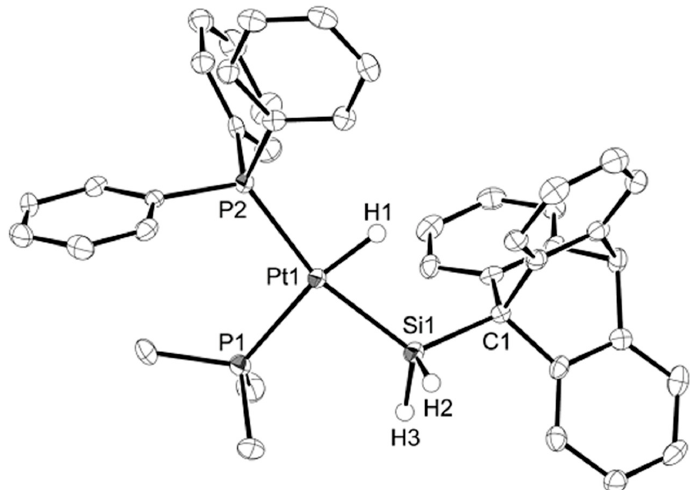
Figure 3. ORTEP of [PtH(SiH 2 Trip)(PMe 3 )(PPh 3 )] 5 50% thermal ellipsoids, a solvation CH 2 Cl 2 molecule, and hydrogen atoms, except H1, H2, and H3 were omitted for clarity. Selected bond lengths